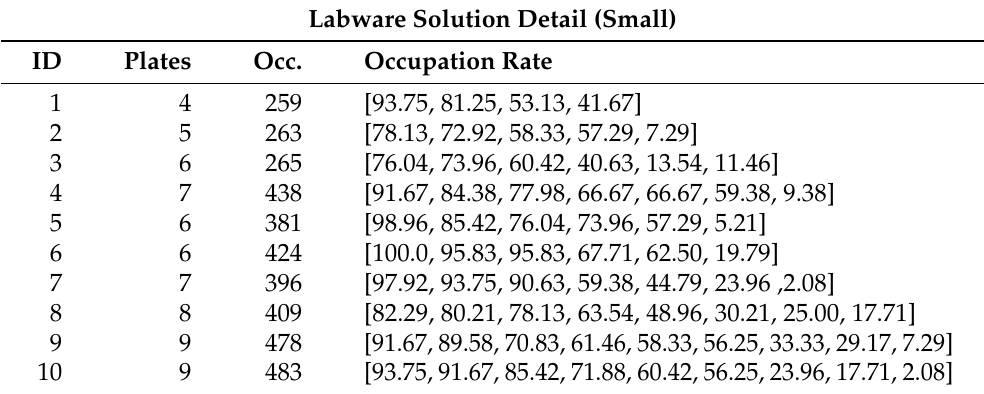
Table A2. Labware solutions detailed for small